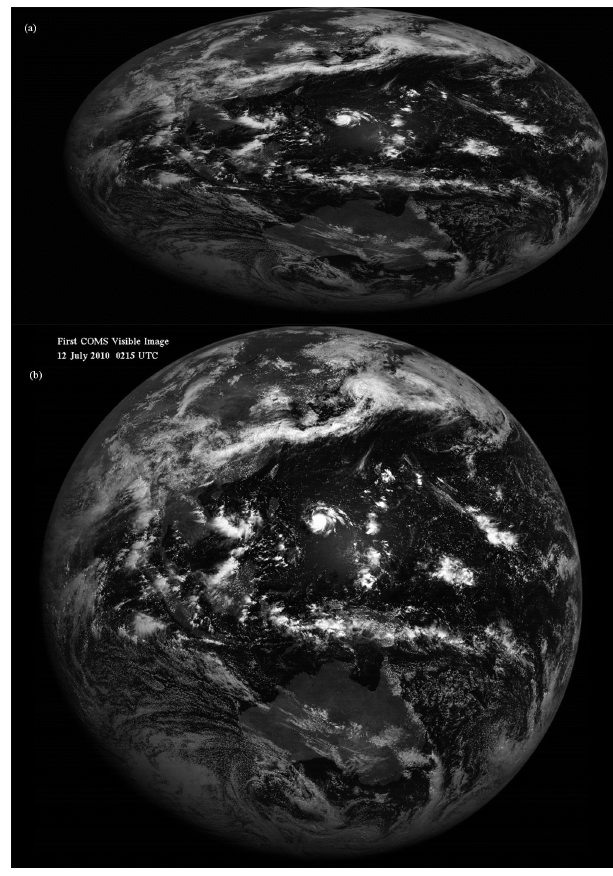
Figure 2. The first visible images of COMS/MI taken on 12 July 2010. (a) is the original 1.75 oversampled image and (b) is the rectified